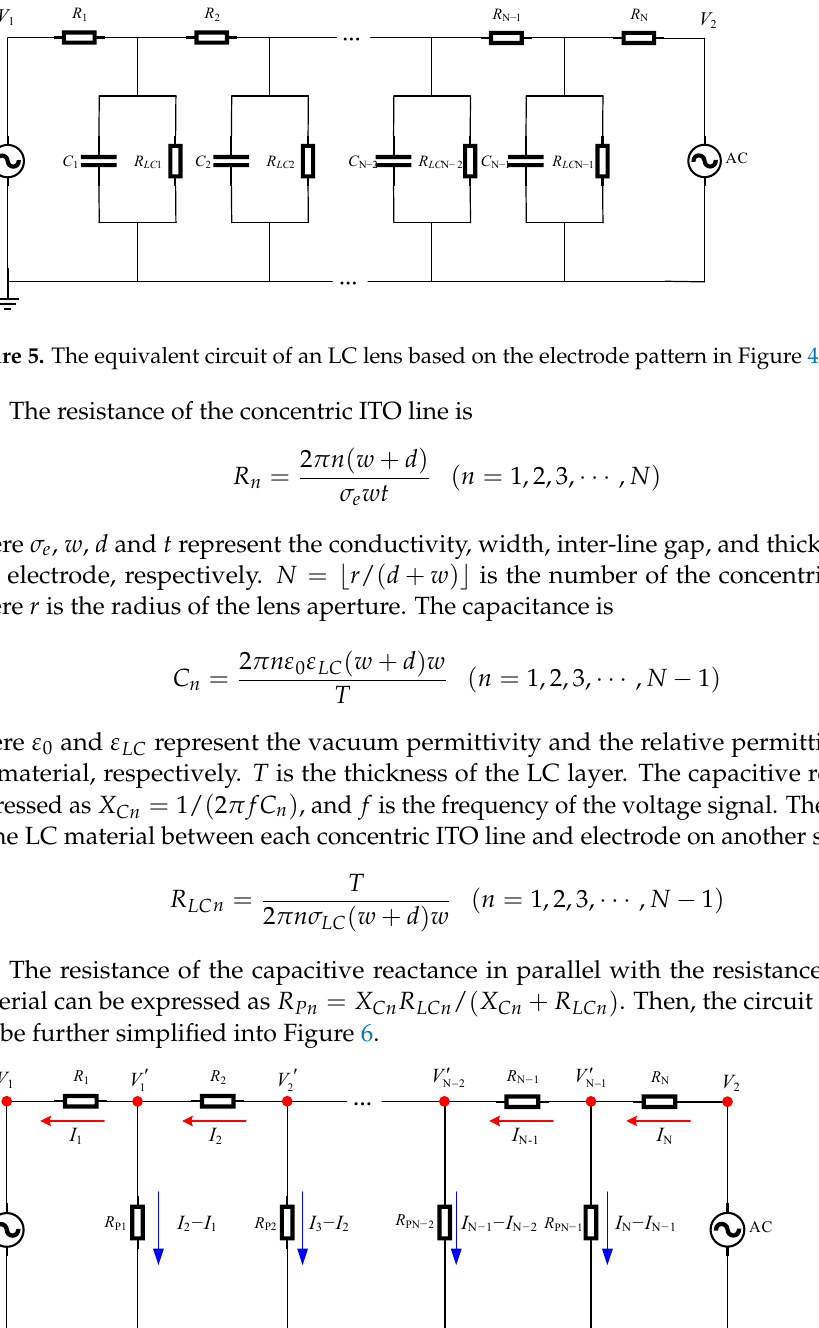
5 can be further simplified into Figure 6.